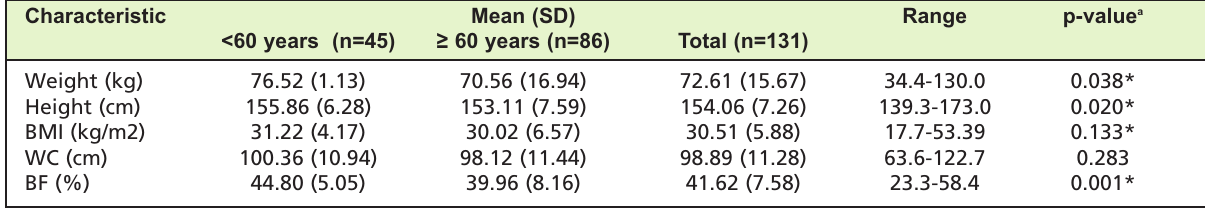
Anthropometric measurements according to age group (n=131) Table II: